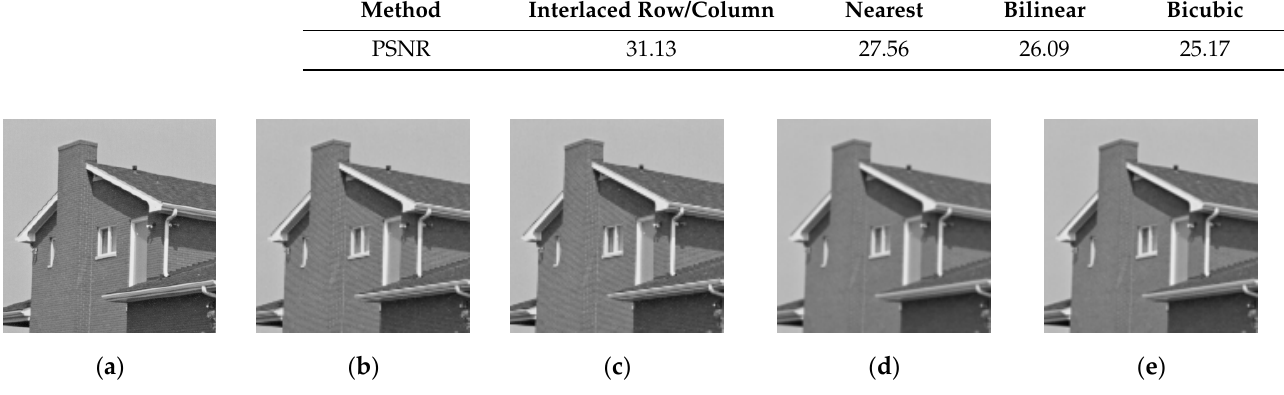
Figure 2. Interpolation results of different downsampling methods. ( a ) test image; ( b ) direct extraction; ( c ) nearest; ( d ) bilinear; ( e ) bicubic. Table 1. A comparison of different downsampling methods with respect to the PSNR (dB).